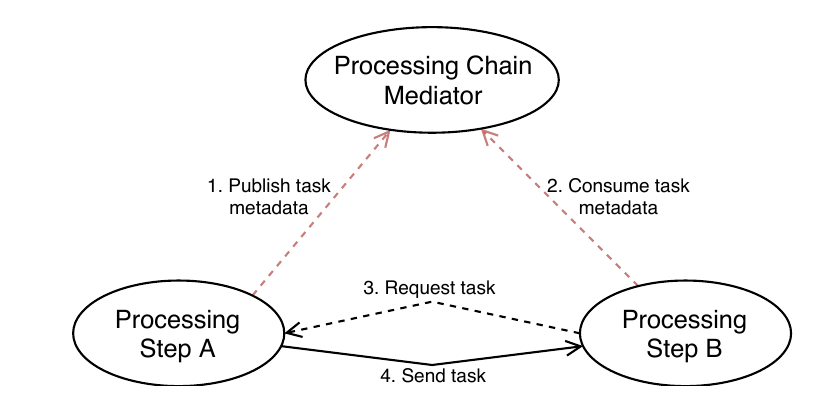
Figure 3. Run-time task